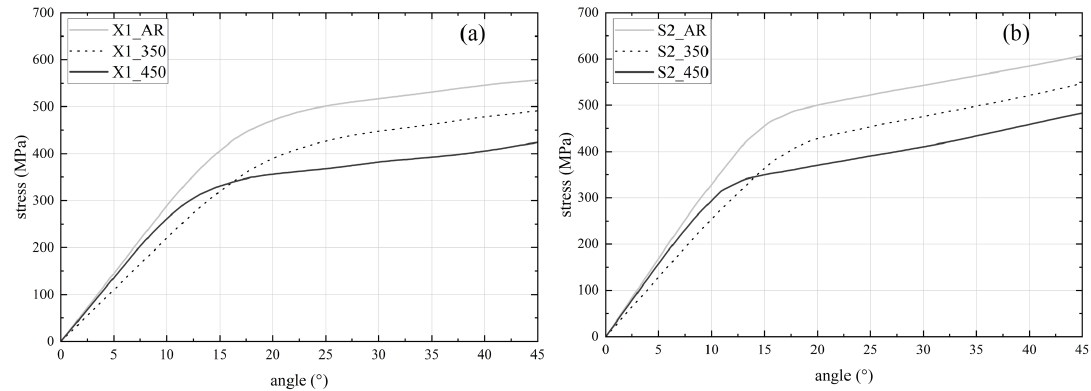
Figure 6. Mean stress curves under bending until 45°: (a) X1 file and their respective heat treatment conditions and (b) S2 file and their respective heat treatment conditions.